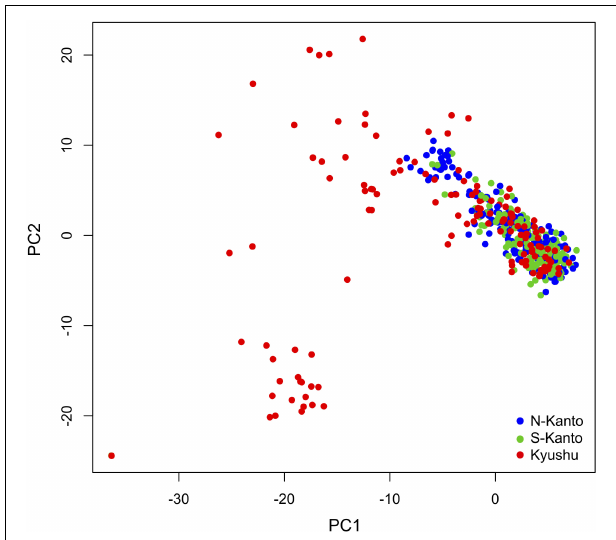
FIGURE 4 | Bi-plot of PCA with PC1 and PC2 based on 6,455 mapped SNPs for N-Kanto, S-Kanto, and Kyushu populations.